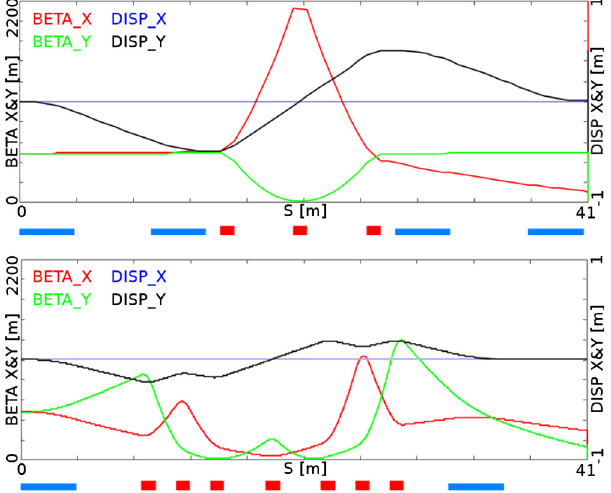
FIG. 6. Optics functions for the two-step vertical spreader (top) compared with the new design of a single-step spreader (bottom). Both plots refer to arc2, the arc4 design being very similar. The scales are equal for both plots.